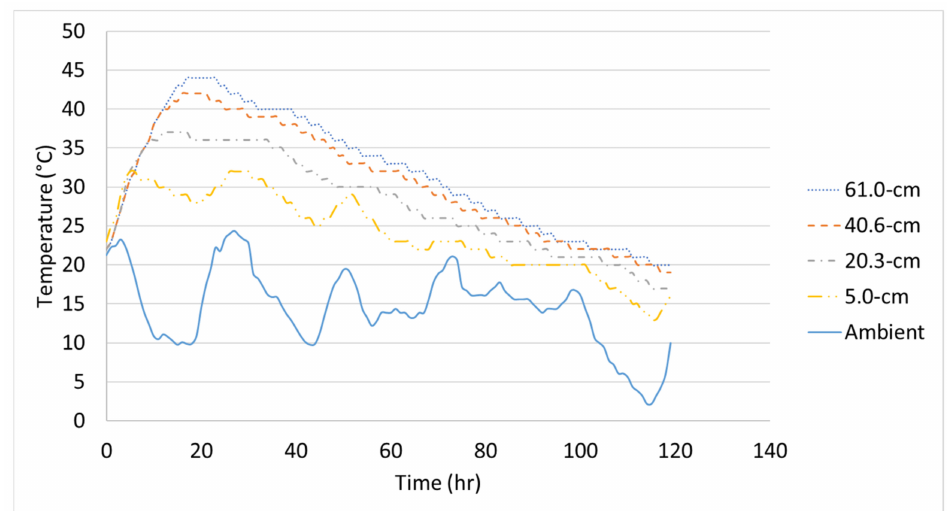
Figure 8. Temperature-time history of Batch 3’s 1.2-m (4-ft)